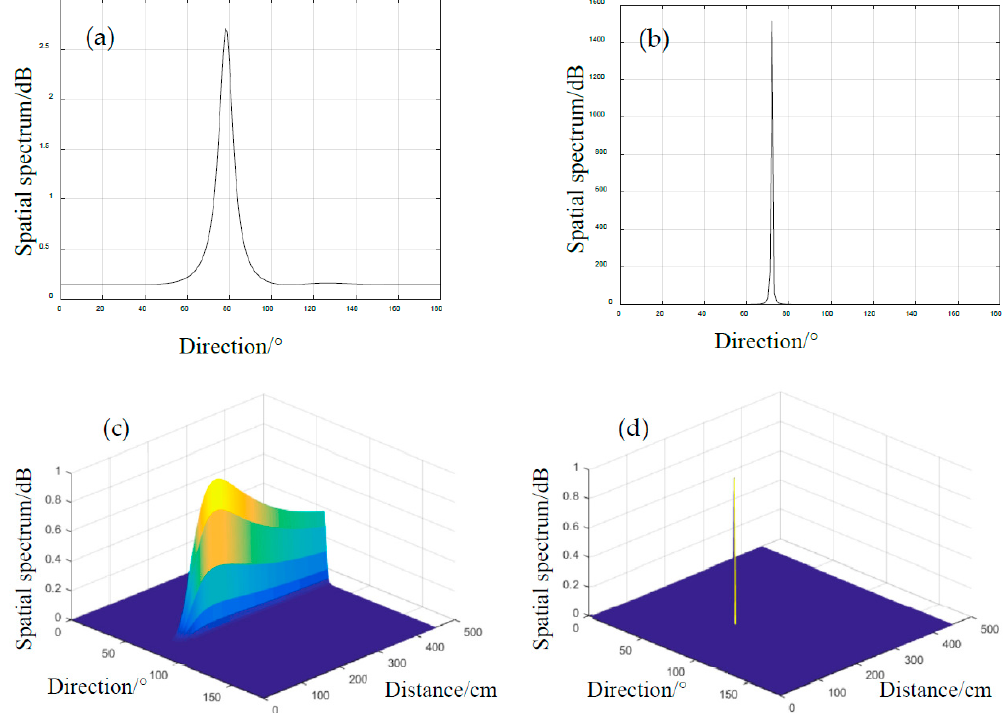
Figure 11. Spatial spectrum of case #2 at (190 mm, 76 ◦ ) estimated by ( a ) classical 1D-MUSIC algorithm, ( b ) error calibration based 1D-MUSIC algorithm, ( c ) standard 2D-MUSIC method and ( d ) the proposed